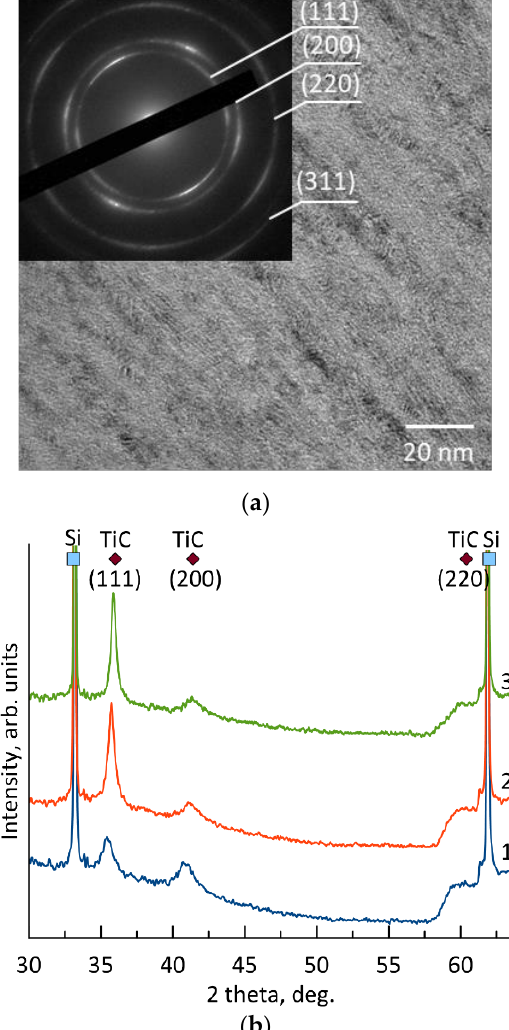
Figure 4. TEM structure image of coating 2 ( a ) and X-ray diffraction patterns ( b ) of coatings 1, 2, and 3.